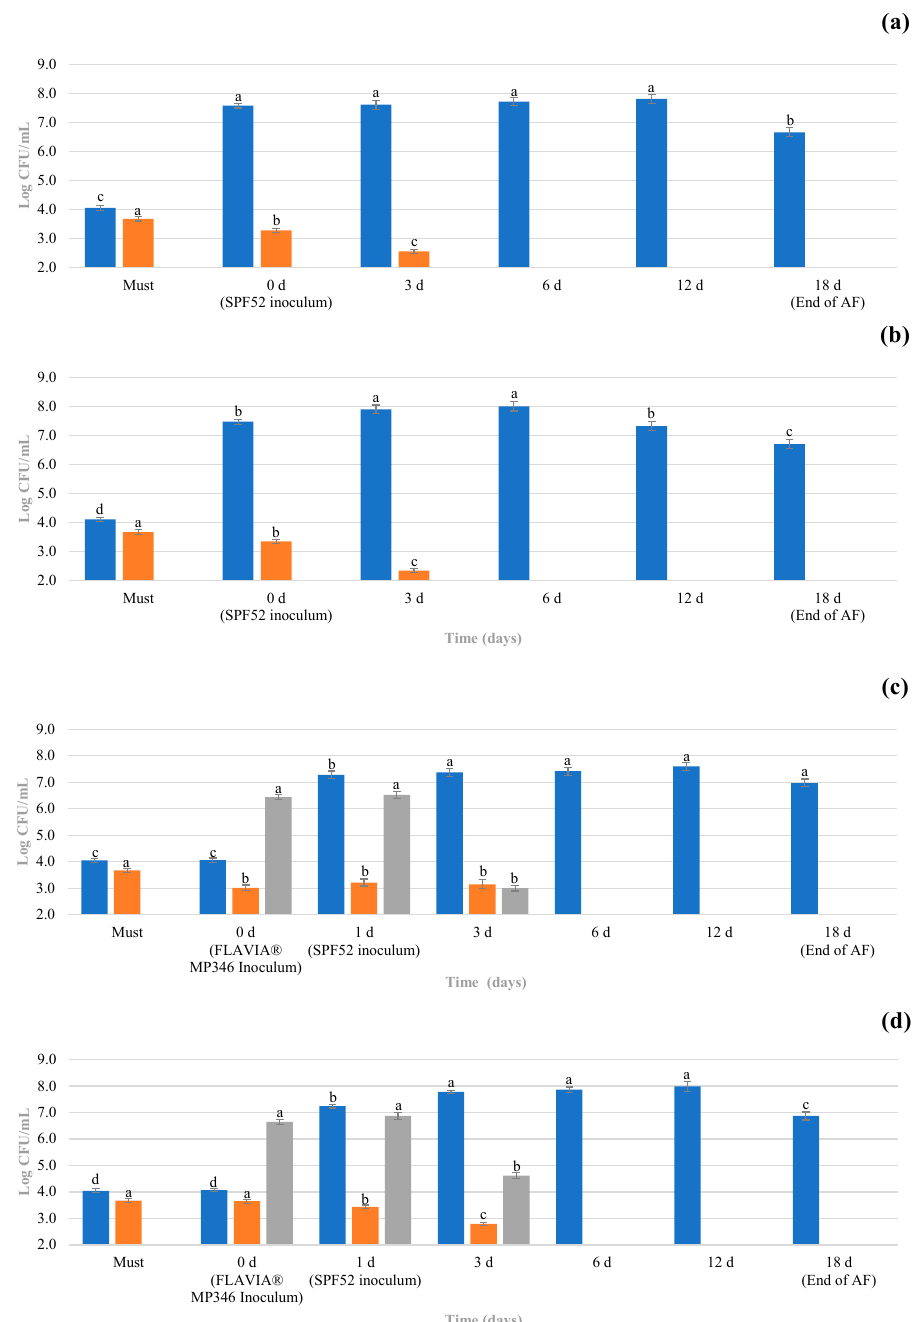
Figure 2. Microbiological concentration (Log CFU/mL) of samples during alcoholic fermentation: ( a ) C1, single inoculum with S. cerevisiae SPF52; ( b ) C2, glutathione-rich inactivated yeasts and single inoculum with S. cerevisiae SPF52; ( c ) T1, sequential inoculum with M. pulcherrima MP346/ S. cerevisiae SPF52; ( d ) T2, glutathione-rich inactivated yeasts and sequential inoculum with M. pulcherrima MP346/ S. cerevisiae SPF52. For each microbiological group, different letters indicate statistically significant values determined by using Tukey’s test ( p ≤ 0.05). Legends: ■ , Presumptive Saccharomyces ; ■ , non- Saccharomyces (except Metschnikowia spp.); ■ , Presumptive Metschnikowia spp. The M. pulcherrima MP346 inoculum concentration in T1 and T2 was close to 6.5 Log CFU/mL. The concentration of PS after the SPF52 inoculum ranged from 7.3 (T1) to 7.6 (C1) Log CFU/mL in all treatments. On day 3 of AF, PS showed an increase to 7.4–8.0 Log CFU/mL for all trials. The NS populations were lower and in the range of 2.3–3.2 Log